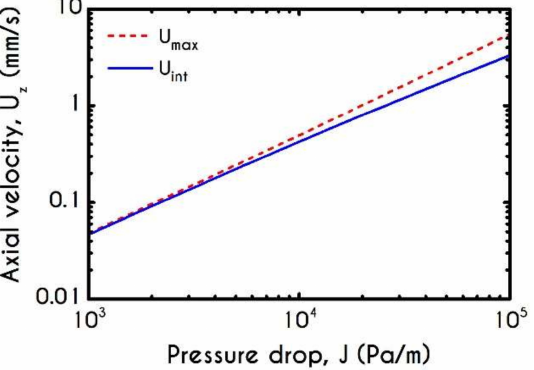
Figure 21. Maximum U max and interfacial velocity U int as a function of pressure gradient J for R = 20 µ m and H c =